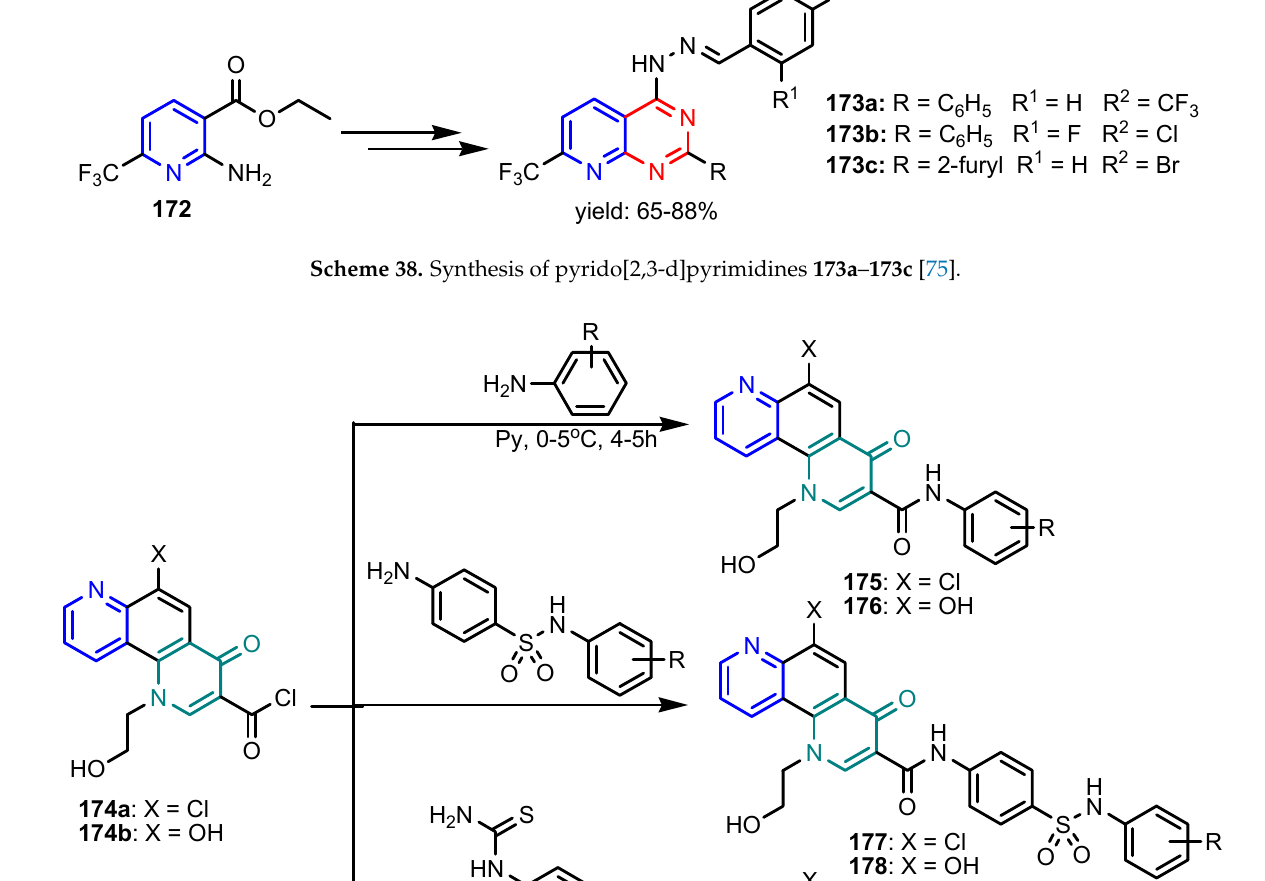
Figure 18. Structures of compounds 184 and 185a – 185h [78].